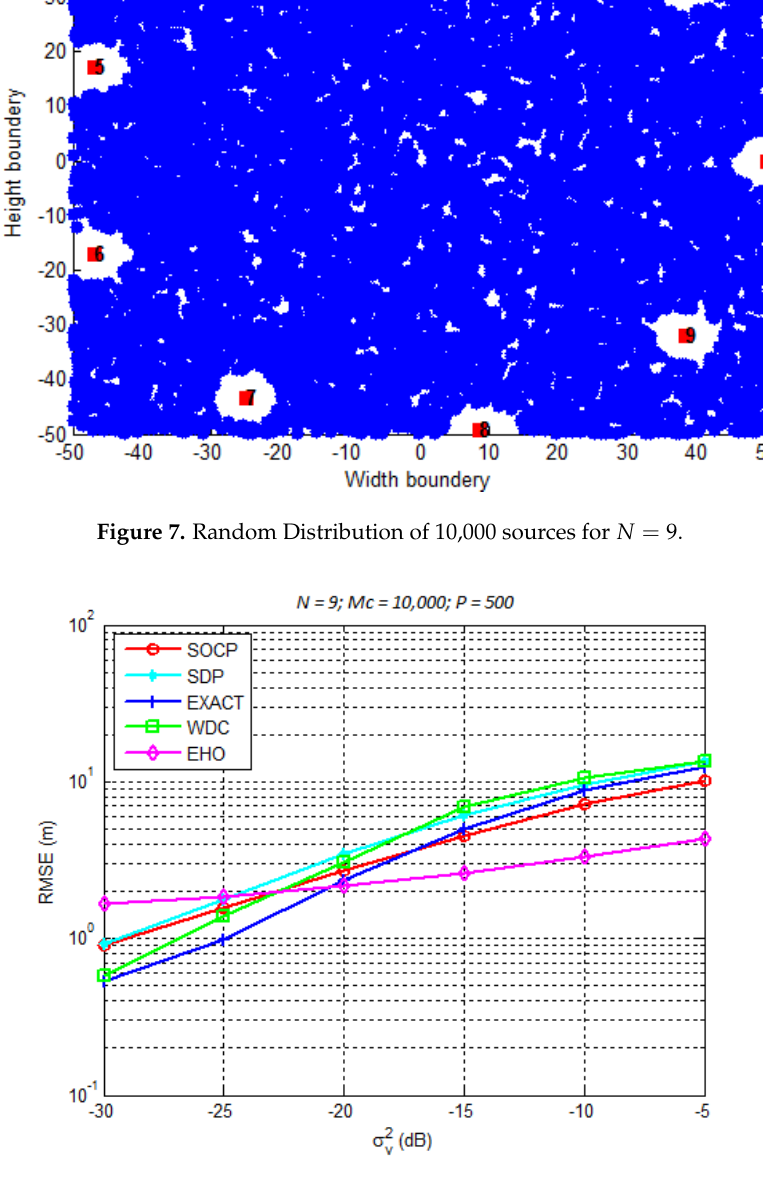
(dB) performance comparison for N = i